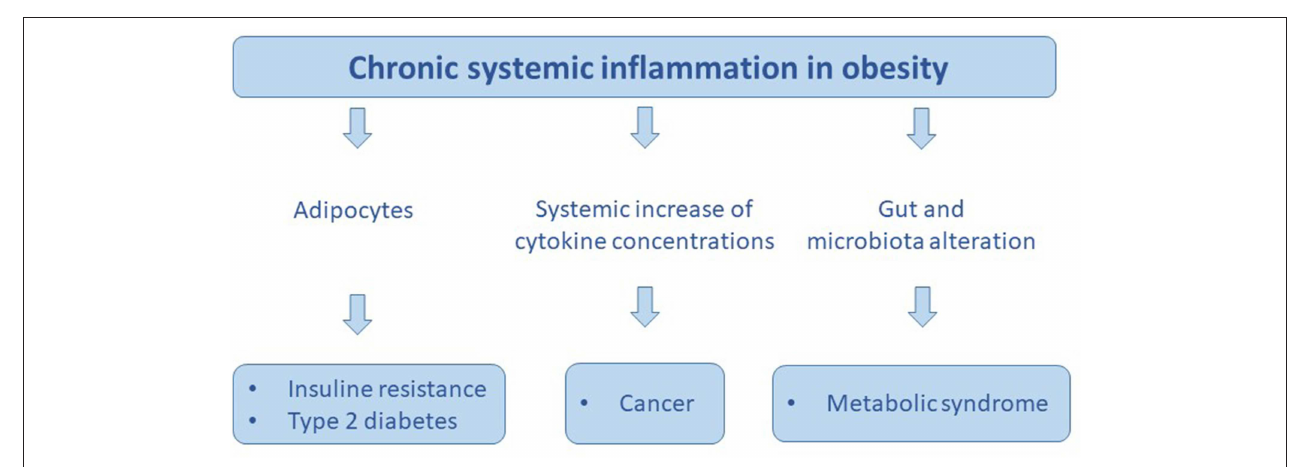
FIGURE 4 | The chronic sistemic inflammation in obesity promotes: insuline resistance, type 2 diabetes, cancer, and metabolic syndrome.